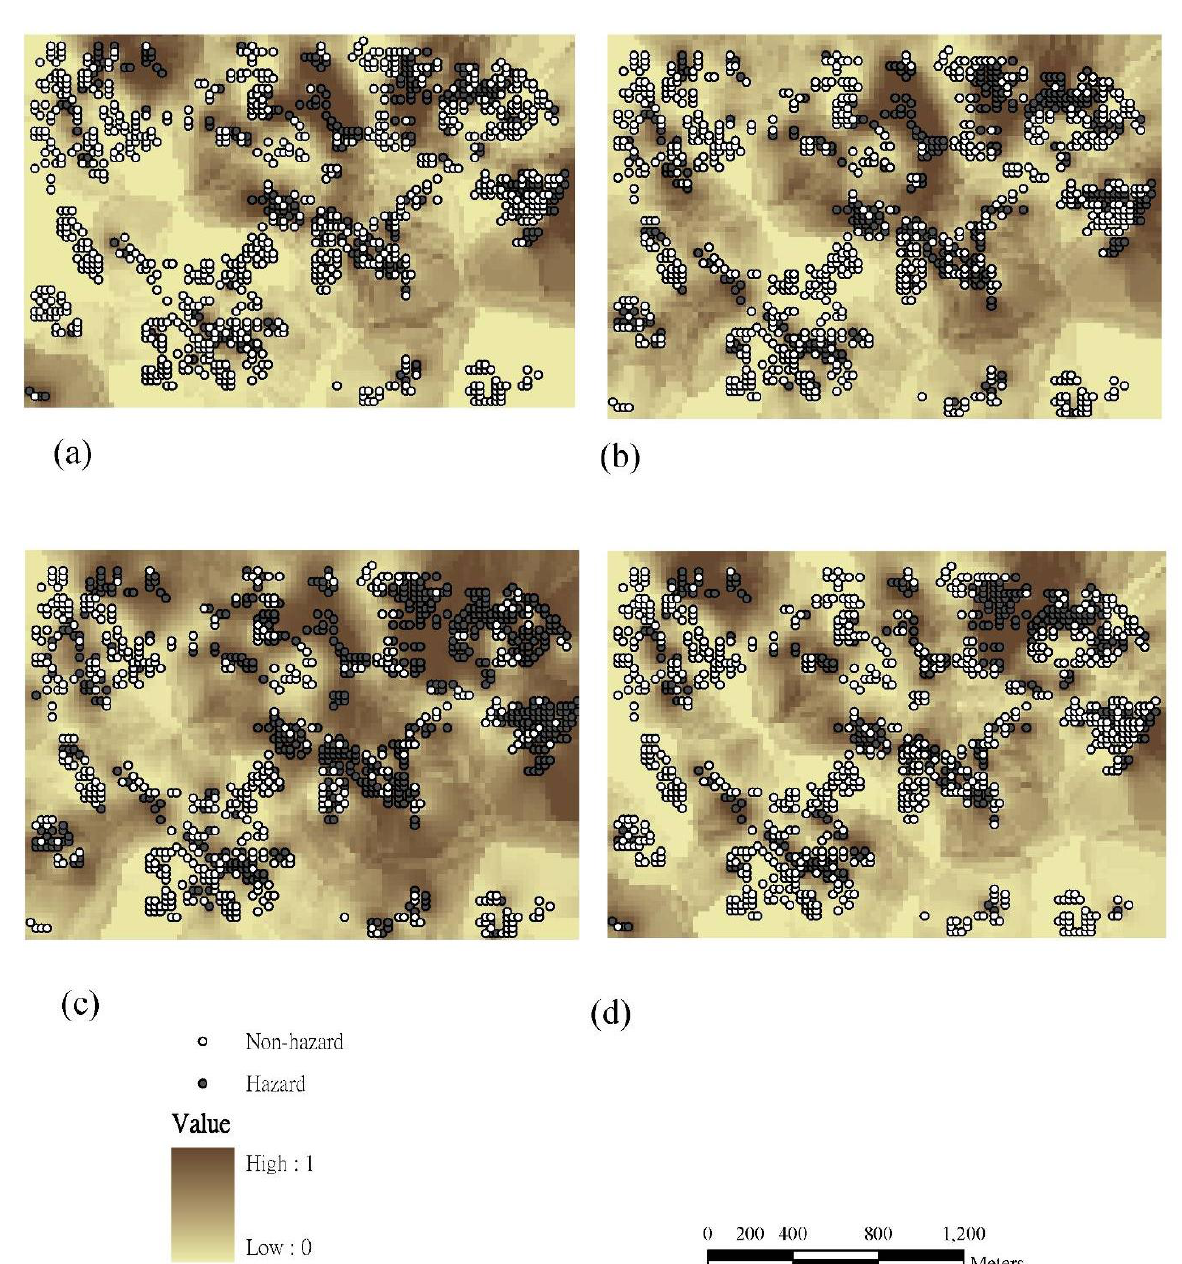
Figure 3. The probability maps of (a) Cr (b) Cu (c) Ni (d) Zn using indicator kriging based on 1,082